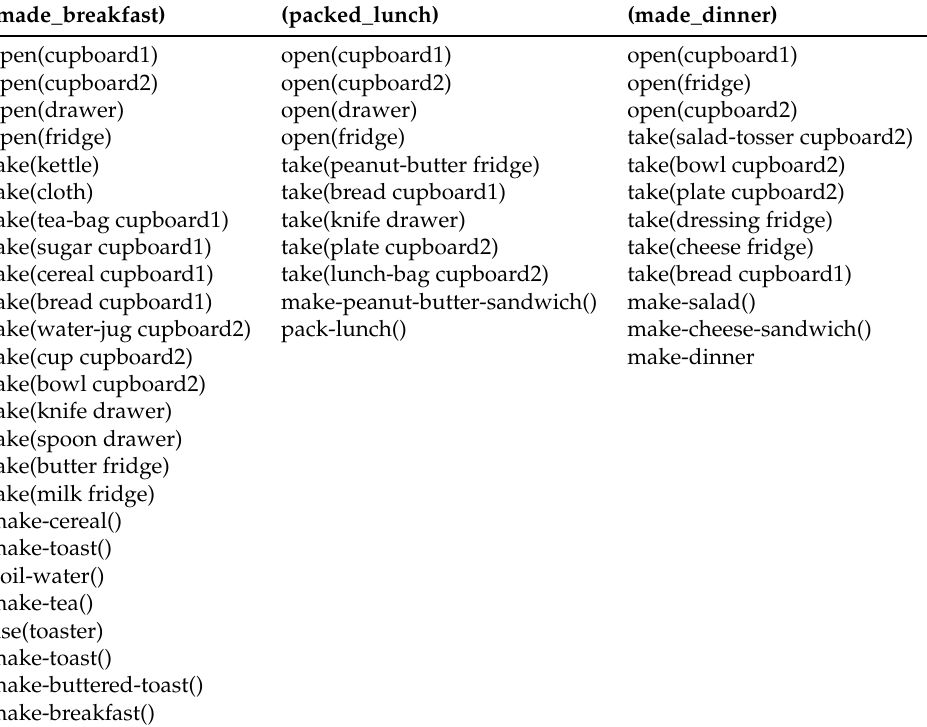
Table A1. Longest plans for the goals from the Kitchen